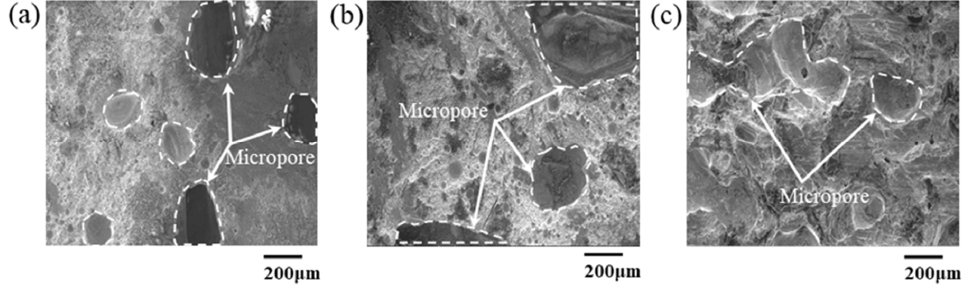
Figure 7. SEM micrographs of the fractured joints obtained under different pressures after shear failure test: ( a ) SEM images at 3 MPa; ( b ) 5 MPa; ( c ) 20 MPa.